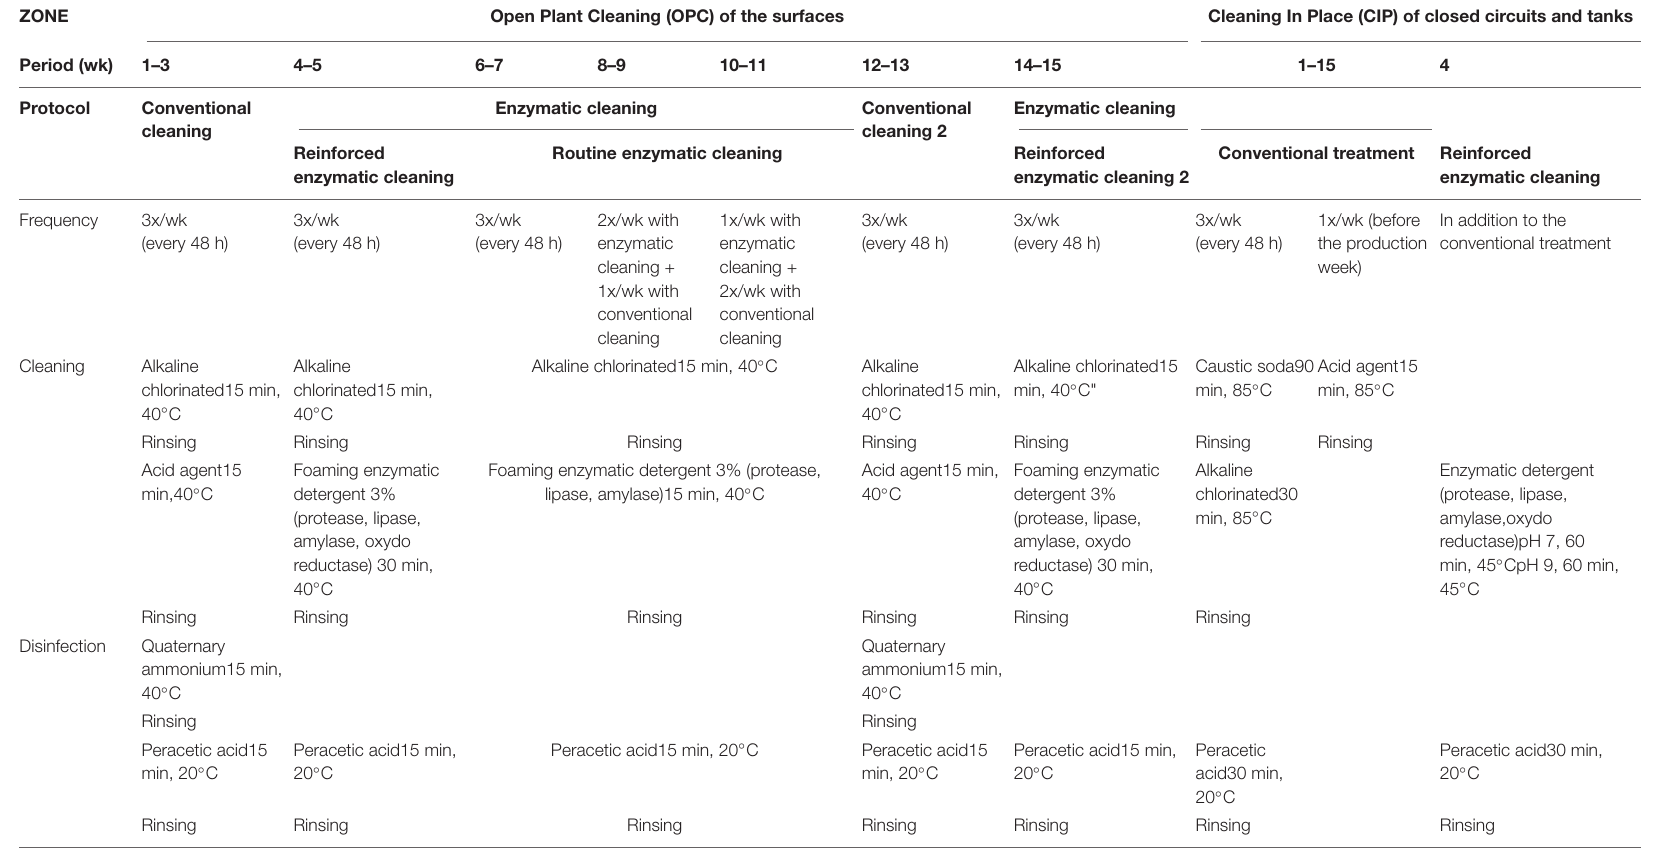
TABLE 1 | Cleaning and disinfection protocols for open surfaces and closed circuits. ZONE Period